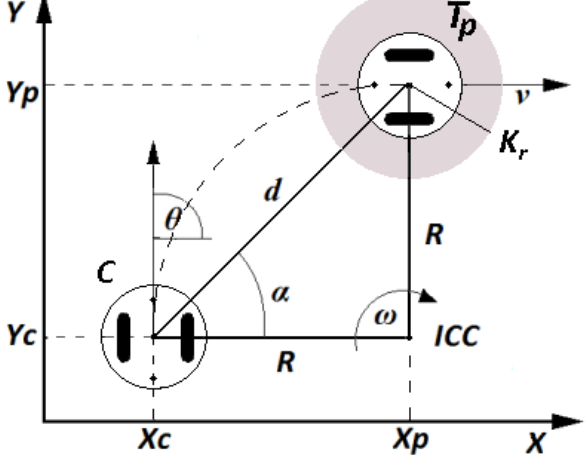
Figure 15. Position control problem.